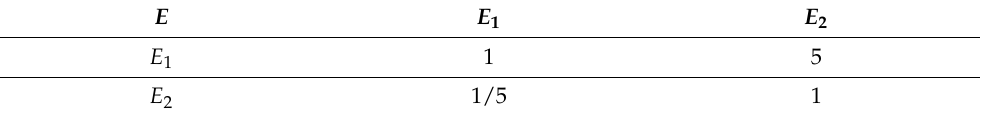
Table 11. Judgment matrix of indicators of environmental conditions in the cave.